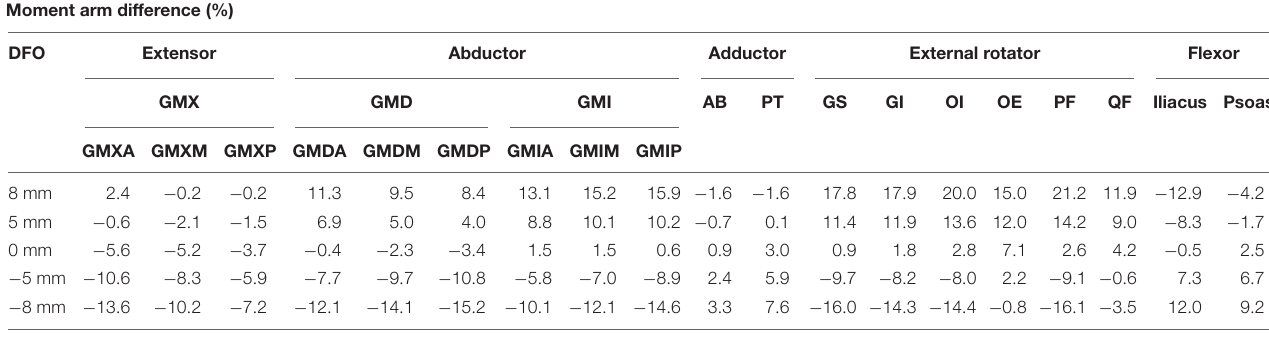
TABLE 2 | The normalized muscle moment arm difference of extensor, abductor, adductor, external rotator and flexor between both sides at different FO differences. Moment arm difference (%) DFO Extensor Abductor Adductor External rotator Flexor GMX GMD GMI AB PT GS GI OI QF Iliacus Psoas